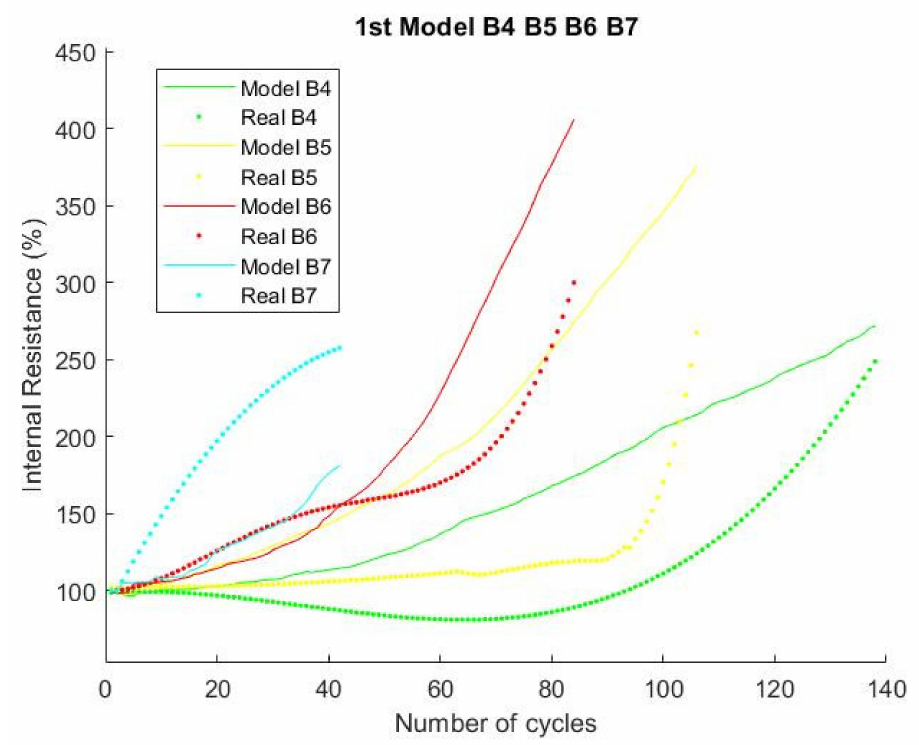
Figure 23. Results of first model for batteries 1, 2, and 3. The accuracy of the first model for batteries 1, 2, and 3 was remarkably high. The R 2 ratings for each battery were R 2 (B1) = 0.9653; R 2 (B2) = 0.9974; R 2 (B3) = 0.9644. However, when testing this first model with some batteries which were not used to train the algorithm, it was found that the results in these cases were not satisfactory (Figure 24).